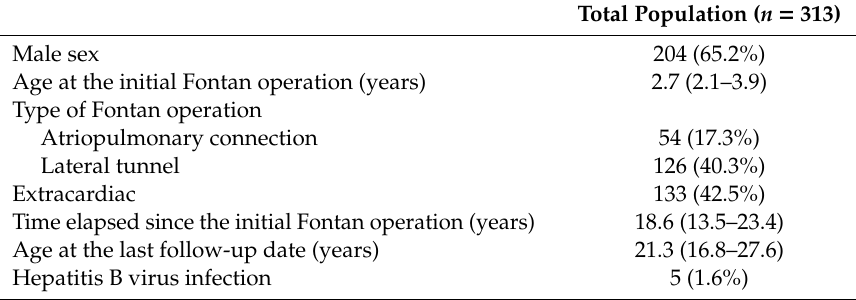
Table 1. Demographics and clinical characteristics of the enrolled